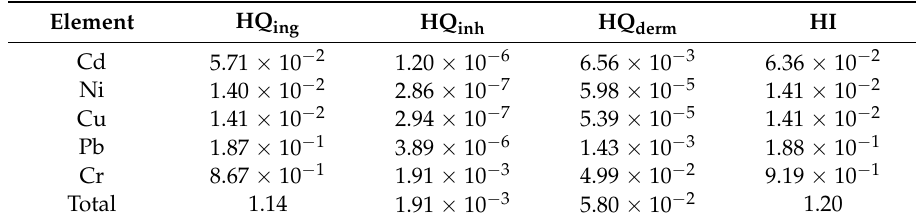
Table 6. Non-carcinogenic exposure risk values (child) of heavy metal in different exposure pathways in Leisure Squares of Yanta District in Xi’an.